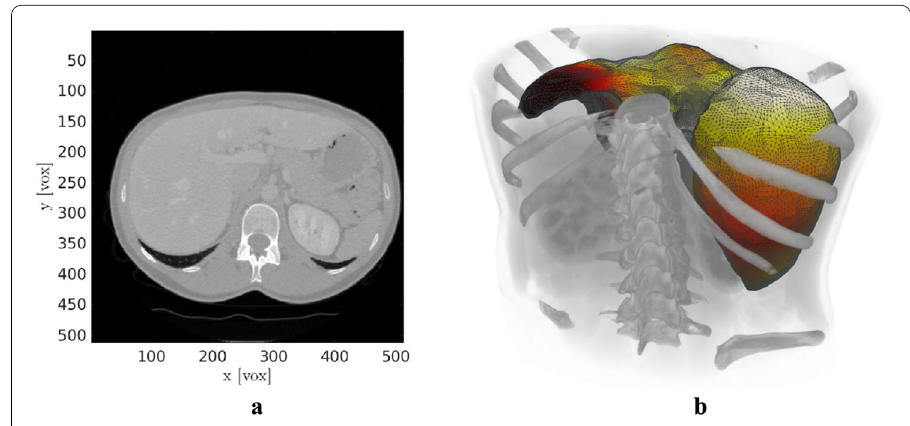
Fig. 2 a Slice of the liver CT scan and b 3D view of the scan with the fine numerical mesh. The color of the liver is chosen according to the amplitude of the first computed vibration mode (cid:2) vib